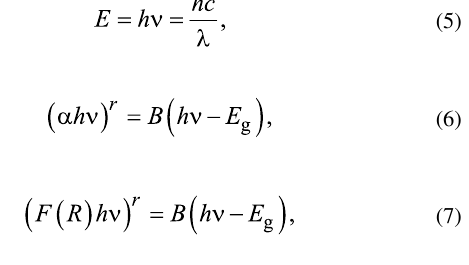
was 1.5 L·min − 1 , and the dosage of catalysts was 0.2 g for all